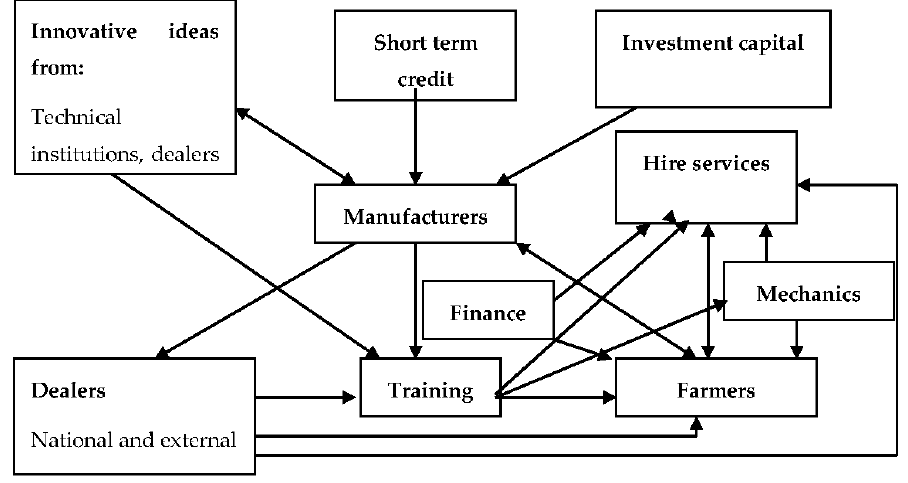
Figure 2. Machinery supply chain for farm machinery manufacturers (source: Sims et al . [34]).